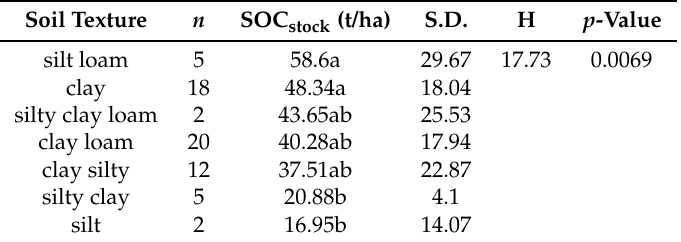
Table 4. Distribution SOC stock (t/ha) in Hz1 only. Different letters indicate significant differences according to the Kruskal–Wallis test ( p <